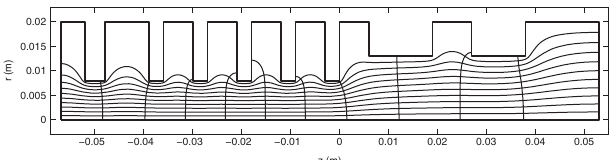
FIG. 8. This figure represents the image of a mapping obtained